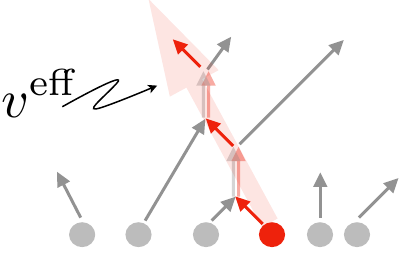
Figure 11: The effective velocity emerges as a tagged quasiparticle travels through the gas. In this cartoon, the scattering shifts arise from time delays due to quasipar- ticles sticking together for a